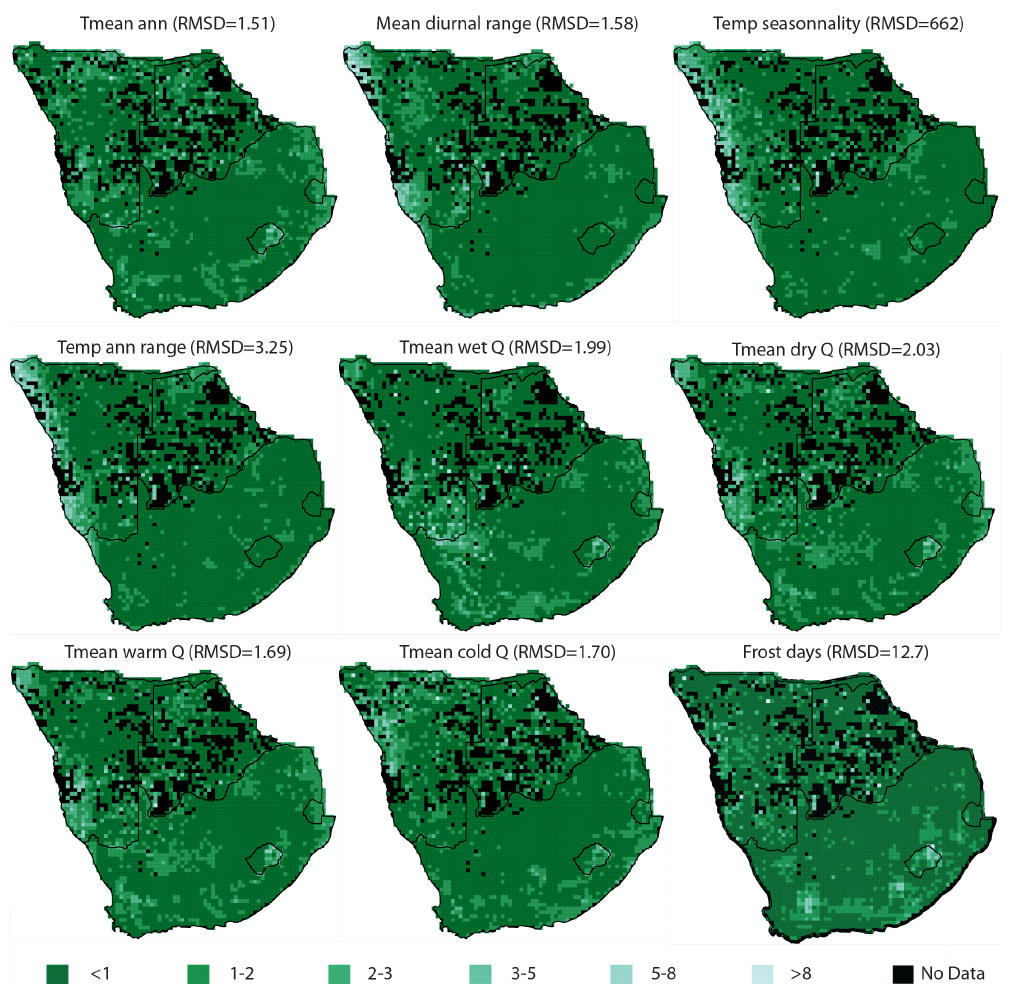
Figure 5. Geographical distributions of the normalized anomalies of the reconstructions of temperature-like variables (Eq. 13). The scale is identical for all the maps, in units of RMSD. No vegetation information was available from the black